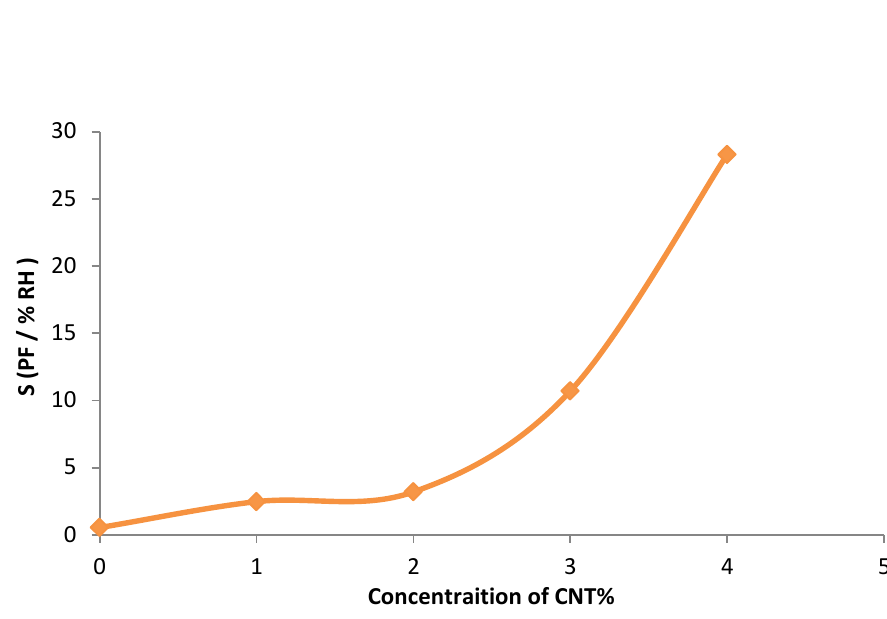
Fig.8: Sensors sensitivity as a function of MWCNT